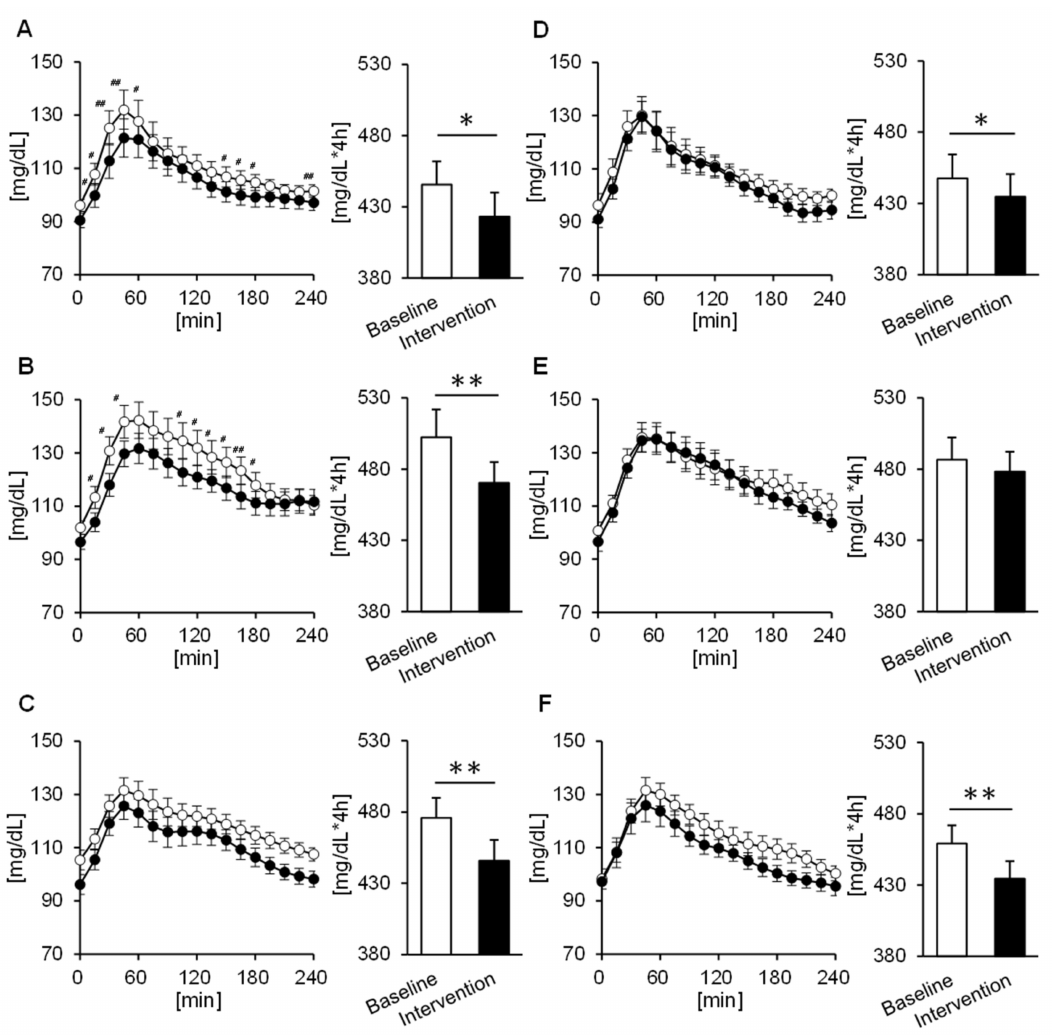
Figure 3. Concentrations of glucose 4 h postprandial and the area under the curve (AUC) in the morning group at ( A ) breakfast, ( B ) lunch, and ( C ) dinner, as well as in the evening group at ( D ) breakfast, ( E ) lunch, and ( F ) dinner. Participants in the morning group took Helianthus tuberosus just before breakfast, and participants in the evening group took it just before dinner. Values are expressed as means and standard errors. # p < 0.05, ## p < 0.01 compared to the baseline level (Bonferroni correction for post-hoc comparisons), * p < 0.05, ** p < 0.01 compared to the baseline level (paired t -test).